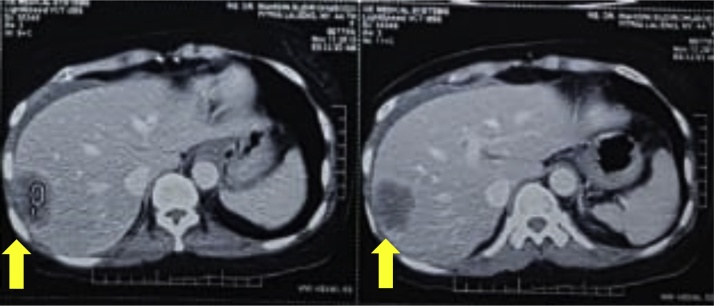
Surveillance MSCT scan with contrast shows hepatomegaly accompanied with right hepatic lobe lesion (yellow arrow).